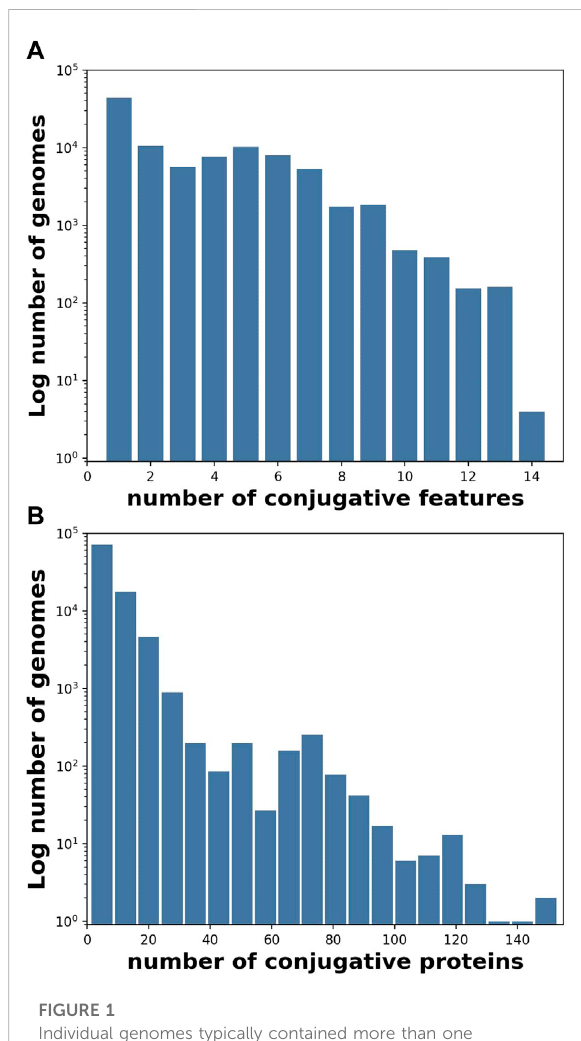
conjugative feature (Table 1), and often contained more than one proteinperfeature. (A) Histogram(logfrequency)ofthenumberof conjugative features per genome, and (B) Histogram (log frequency) of the number of conjugative proteins per genome for all 106,433 genomes containing at least one conjugative